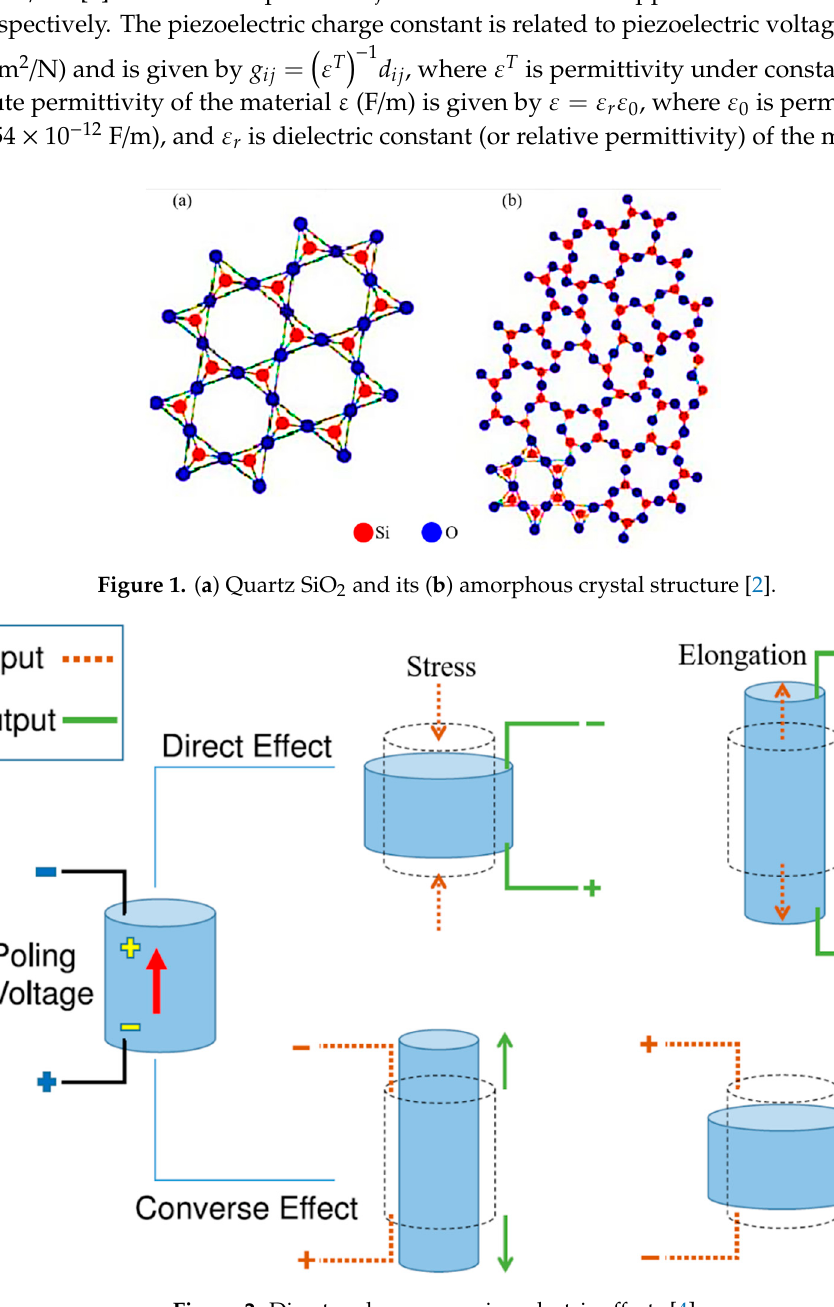
Figure 2. Direct and converse piezoelectric effects [4].